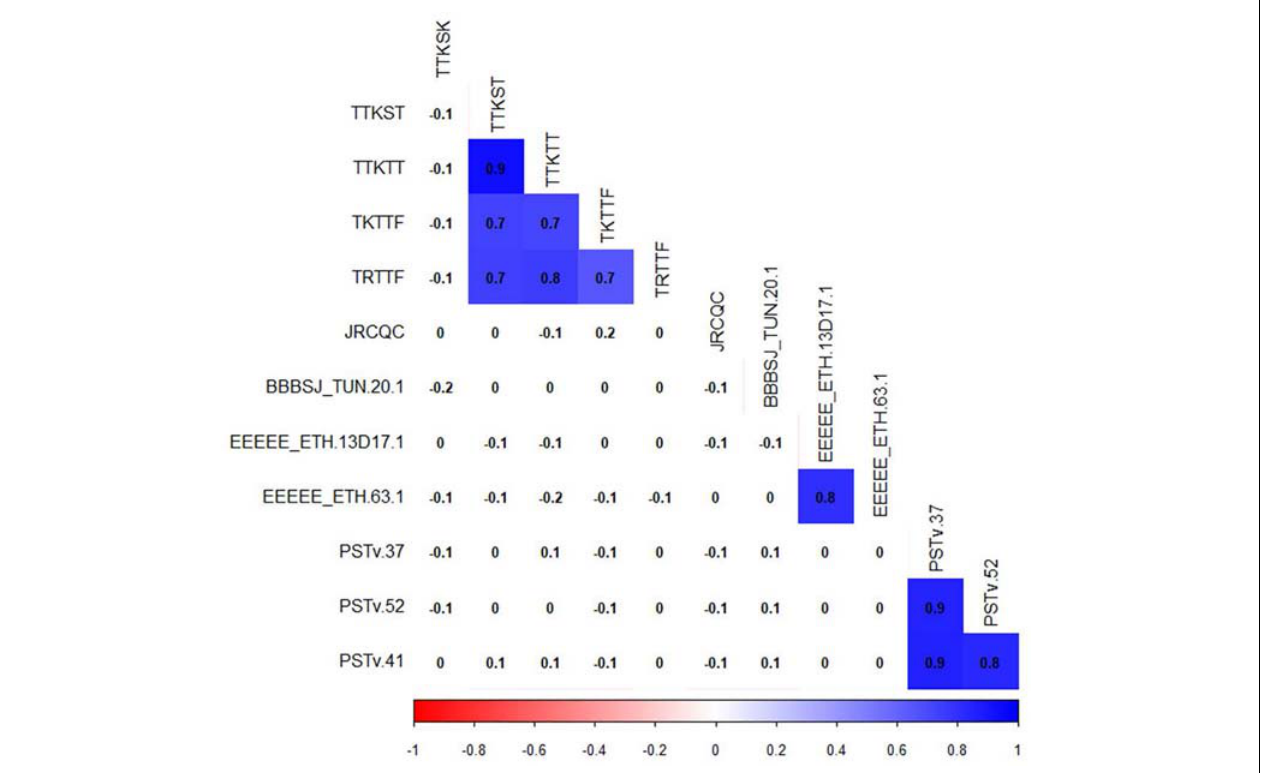
FIGURE 4 | Correlation between durum wheat line infection types to leaf rust, stem rust, and stripe rust pathogen races. Cells with significant correlations at P -value < 0.05 were in blue